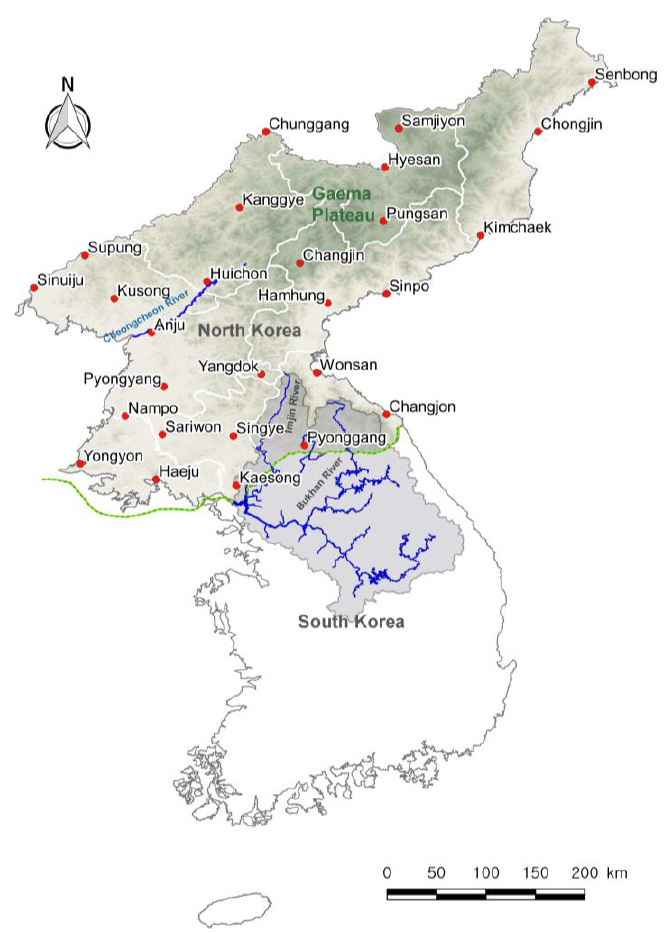
Figure 2. Map showing study area and meteorological stations in North Korea along with rivers shared between South and North Korea. Table 1. The 25 GCMs of the Coupled Model Intercomparison Project Phase 5 (CMIP5) used in this study.